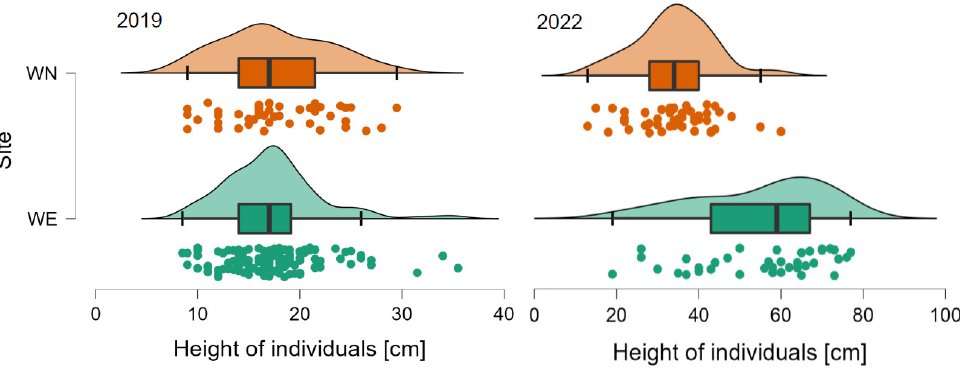
Figure 4. Effect of habitat conditions on the growth rate of Salix lapponum individuals. Individuals reintroduced in 2019 on inactive quaking bog in the eastern part of Lake Wiejki (WE) three years later (2022) were almost twice as tall as those planted on active quaking bog in the northern part of the site (WN).